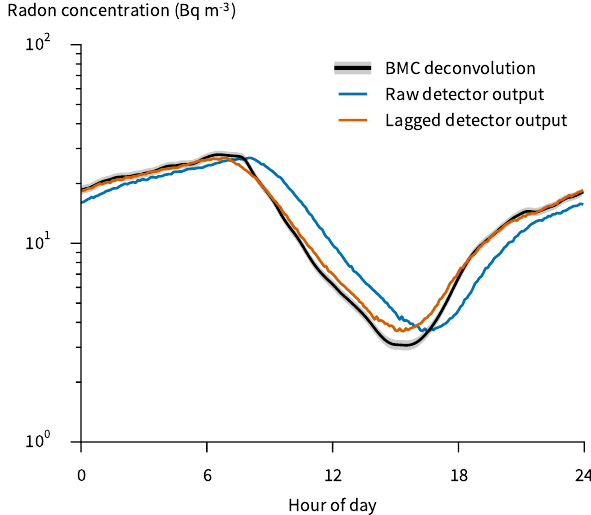
Figure 10. Composite diurnal cycle from the Richmond 1500L de- tector during 2 weeks of consecutive stable nights and clear-sky days. BMC deconvolution means the Bayesian Monte Carlo decon- volution method from Sect. 3.3 and the 16th—84th percentile range is shaded grey. A lag correction of 72 minutes maximises the cor- relation between the lagged detector output and the deconvolved output. See Chambers et al. (2015b) for site